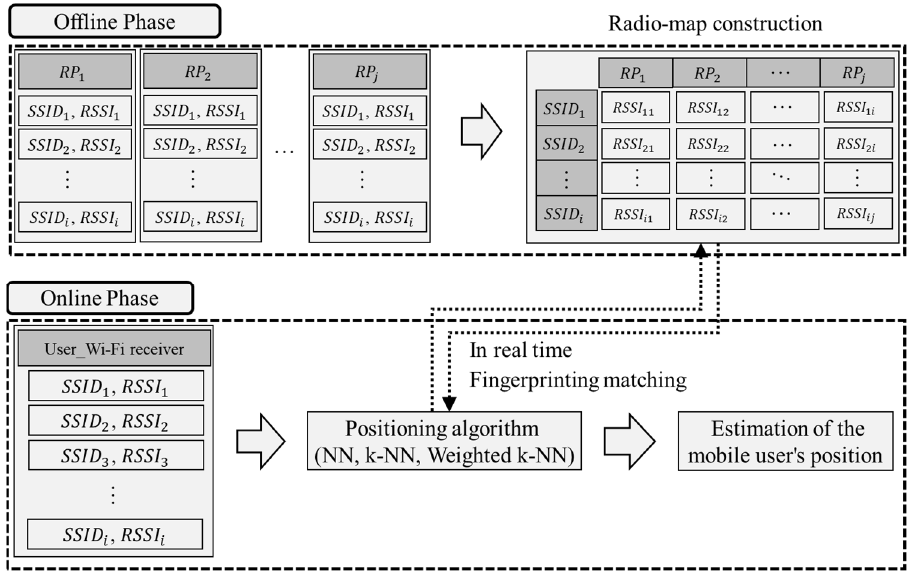
Figure 1. Structure of a typical fingerprint.